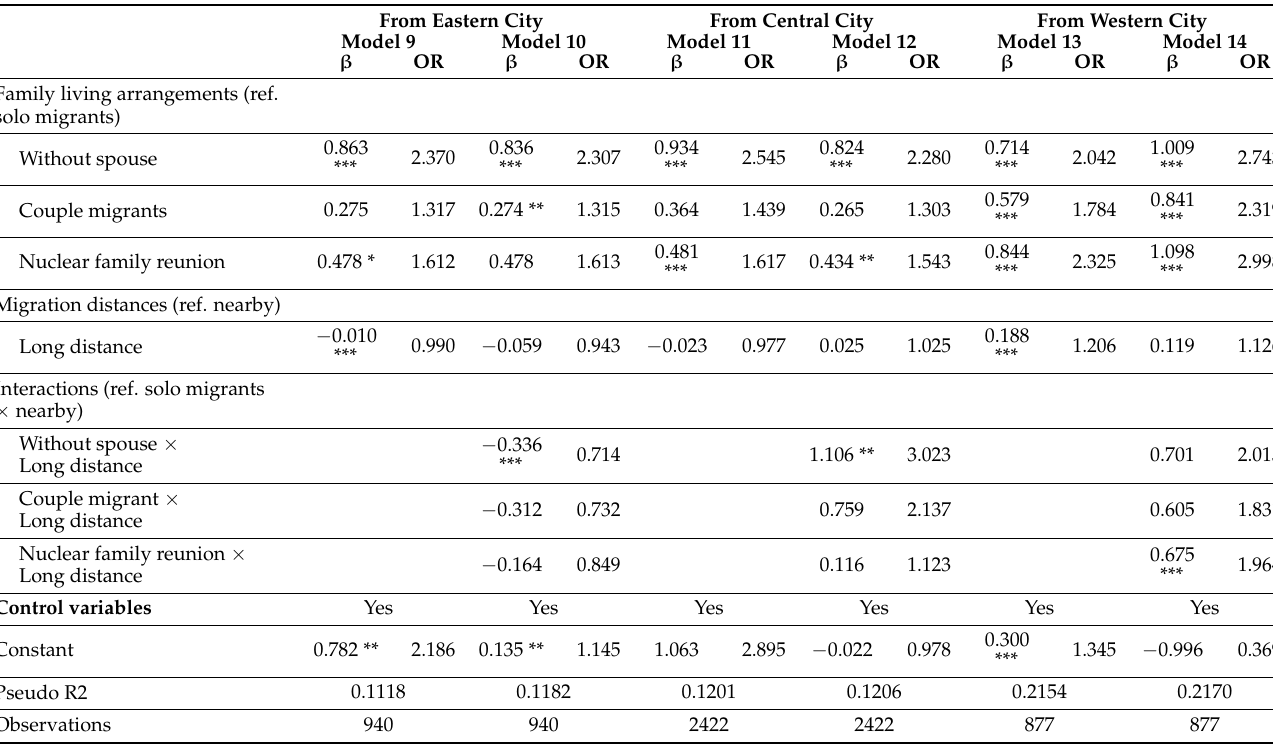
Table 5. Logit regression results for family migrants’ settlement intentions (by outflowing cities). From Eastern City From Central